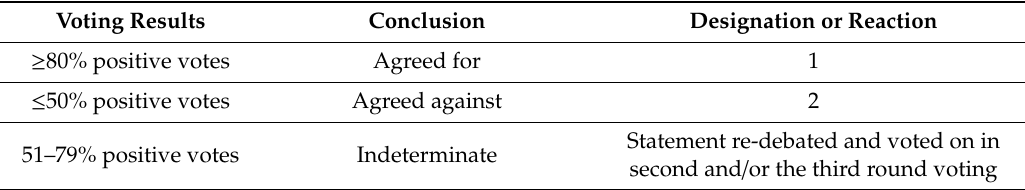
Table 1. Degree of experts’ agreement, Delphi